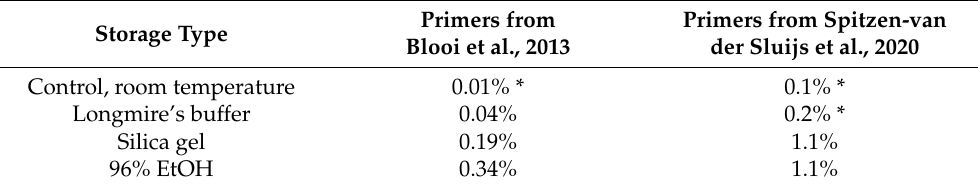
Table 2. Our study comparison of the storage effect on eDNA capture (percentage of eDNA recovered from the original amount added) after six weeks of filters with different storage types (each type three filters) based on two quantification PCR assays from